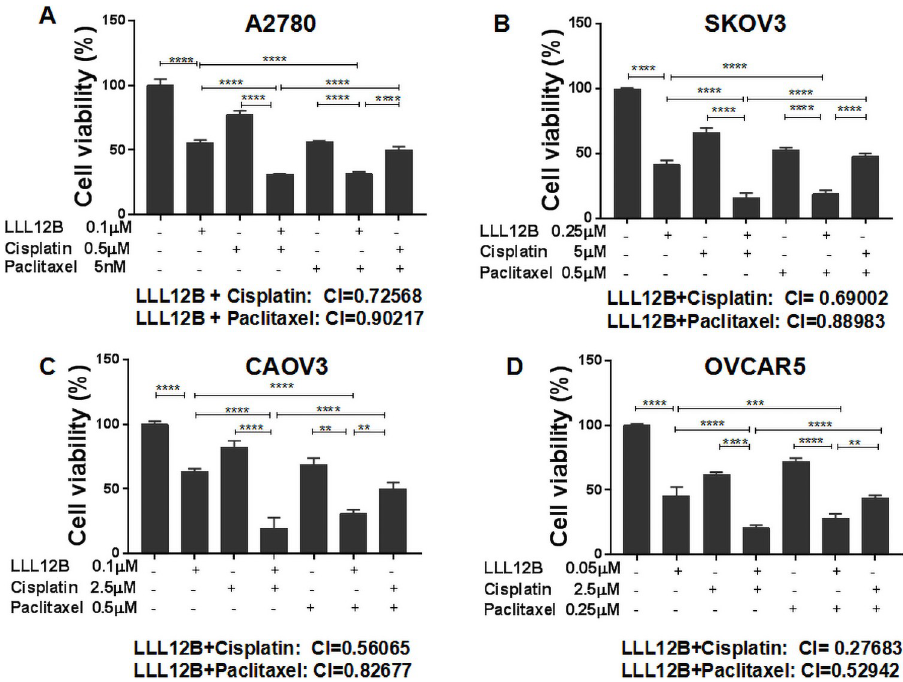
Fig 3. The effects of LLL12B, cisplatin, paclitaxel, and drug combination on cell viability. MTT assays were performed to evaluate cell viability. A-D LLL12B inhibited cell viability of ovarian cancer cells, which were synergistically inhibited when LLL12B was combined with cisplatin or paclitaxel. The differences were found to be significantly different at � p < 0.05, �� p < 0.01, ��� p < 0.001 and ���� p < 0.0001.